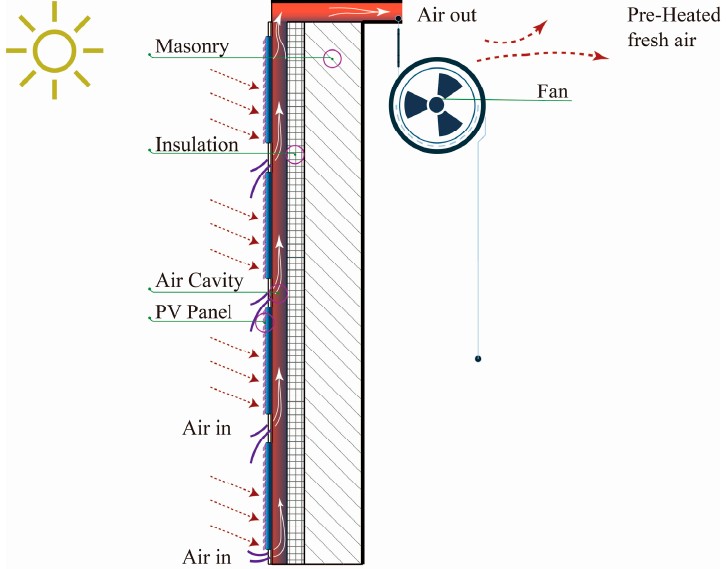
Figure 1. Schematic view of the components of the HAB-BIPV/T system. A new concept of air utilization index (AUI) is introduced in hopes of reliably char- acterizing the thermal behavior of the system with a single indicator, which can easily reflect the level of heat transfer between the PV module and the fresh air in the cavity. The AUI concept is an analogy from the energy utilization coefficient (EUC) in the field of air conditioning, which can characterize the energy efficiency of the airflow distribution mode. EUC is determined as the ratio of the difference in supply and exit air temperatures to the difference in supply and indoor air temperatures [41]. A higher EUC shows that the supply air is used more efficiently to warm the occupied zone, leading to greater energy efficiency [42]. For this system, the AUI is then defined as the ratio of the temperature vari- ation of the air in the cavity to the maximum possible temperature difference, as shown in Equation (1), thus a more significant indicator implies a more adequate heat exchange, and conversely a less optimal one. Meanwhile, in addition to the proposed indicator AUI, the average temperature of the PV module and the air outlet temperature were also